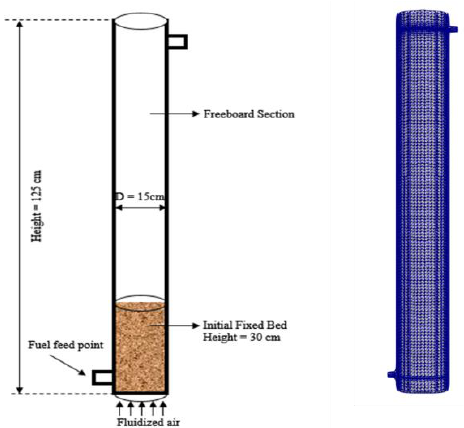
Figure 1. Schematic of fluidized bed gasifier. Table 3. Industrial analysis and elemental analysis of biomass particles.